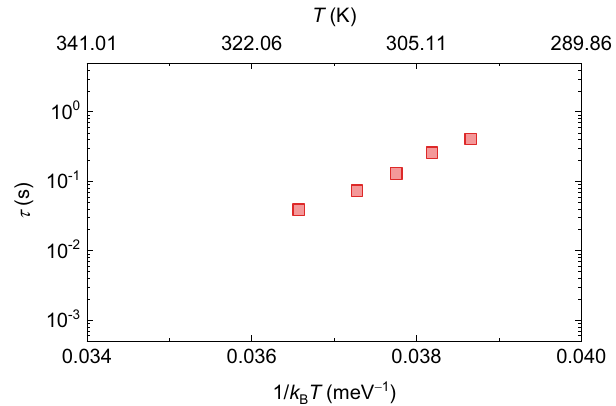
Fig. 4 Average residence times in the local dynamics of a skyrmion. The average residence time τ of a skyrmion pinned in a L or S state shown in Fig. 1b as a function of the temperature T